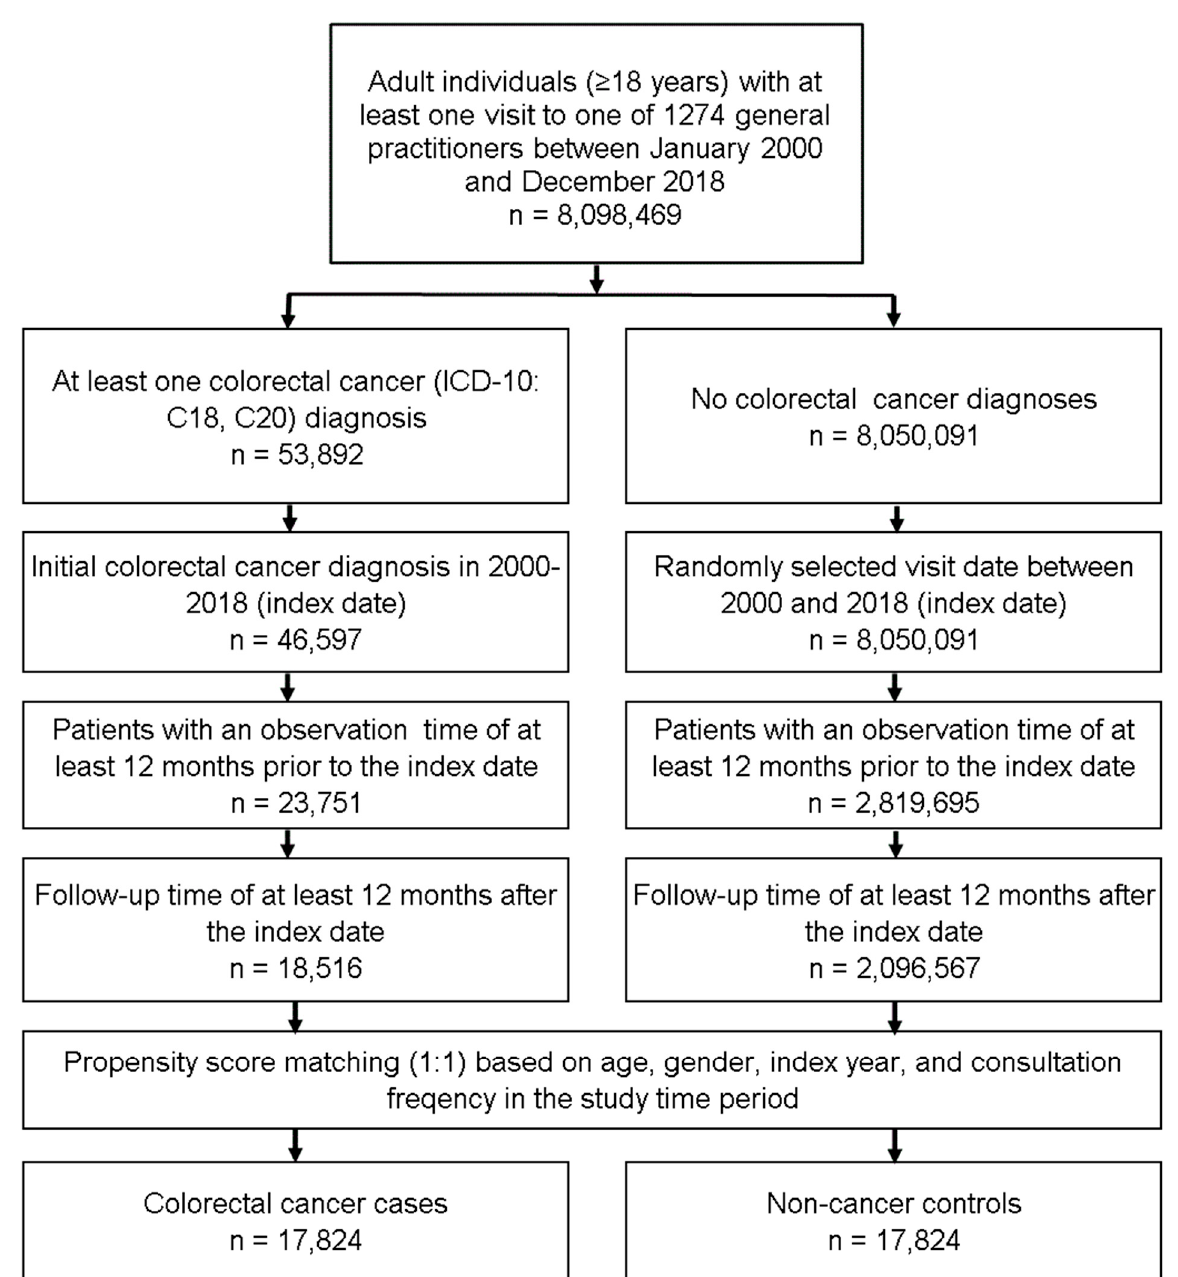
Figure 1. Selection of study patients.